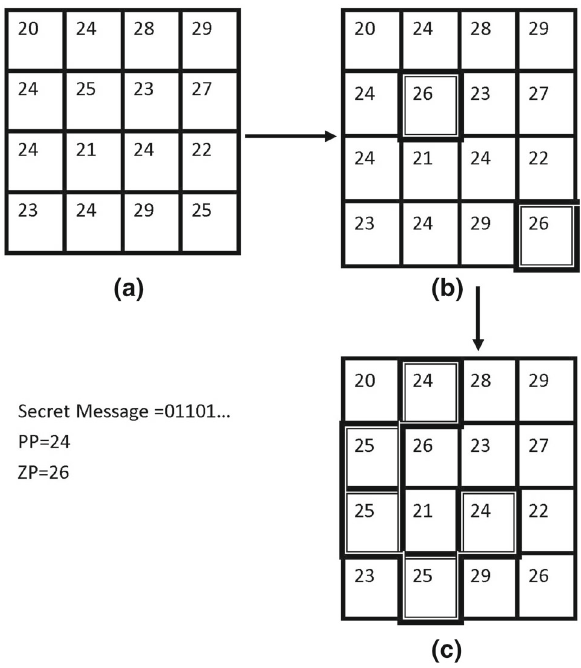
Fig. 5 Histogram modification example